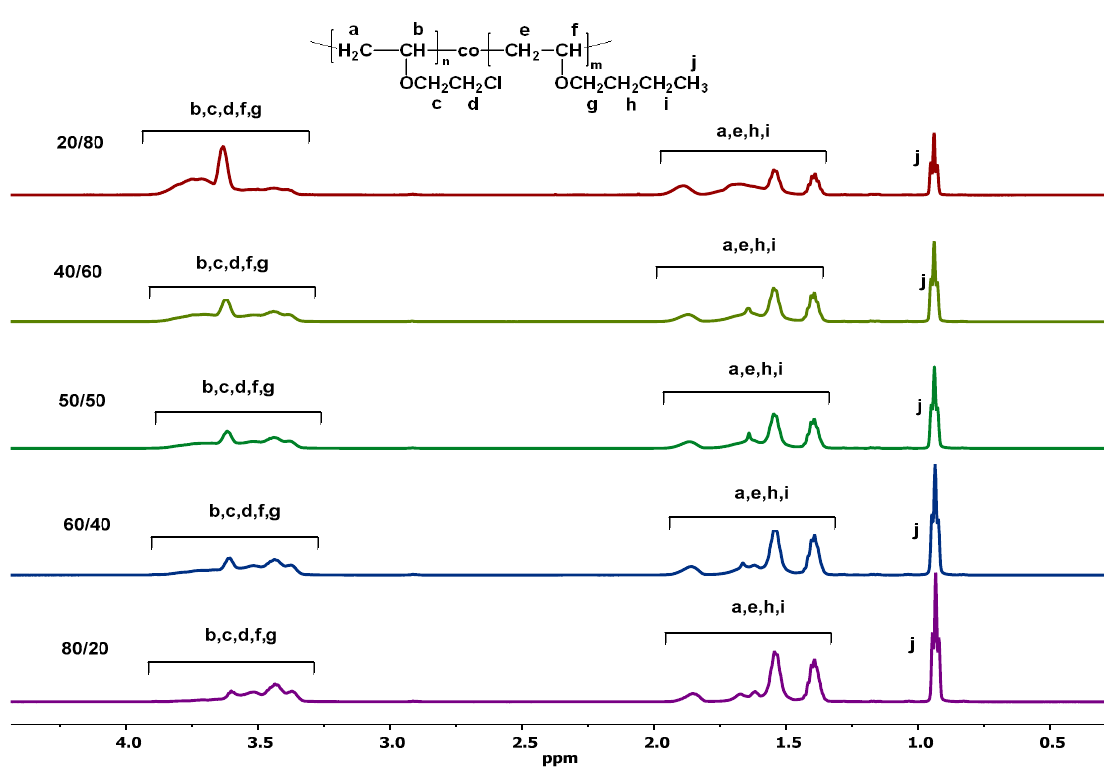
Figure 1. 1 H NMR spectrum of the statistical copolymers PBVE– co –PCEVE.